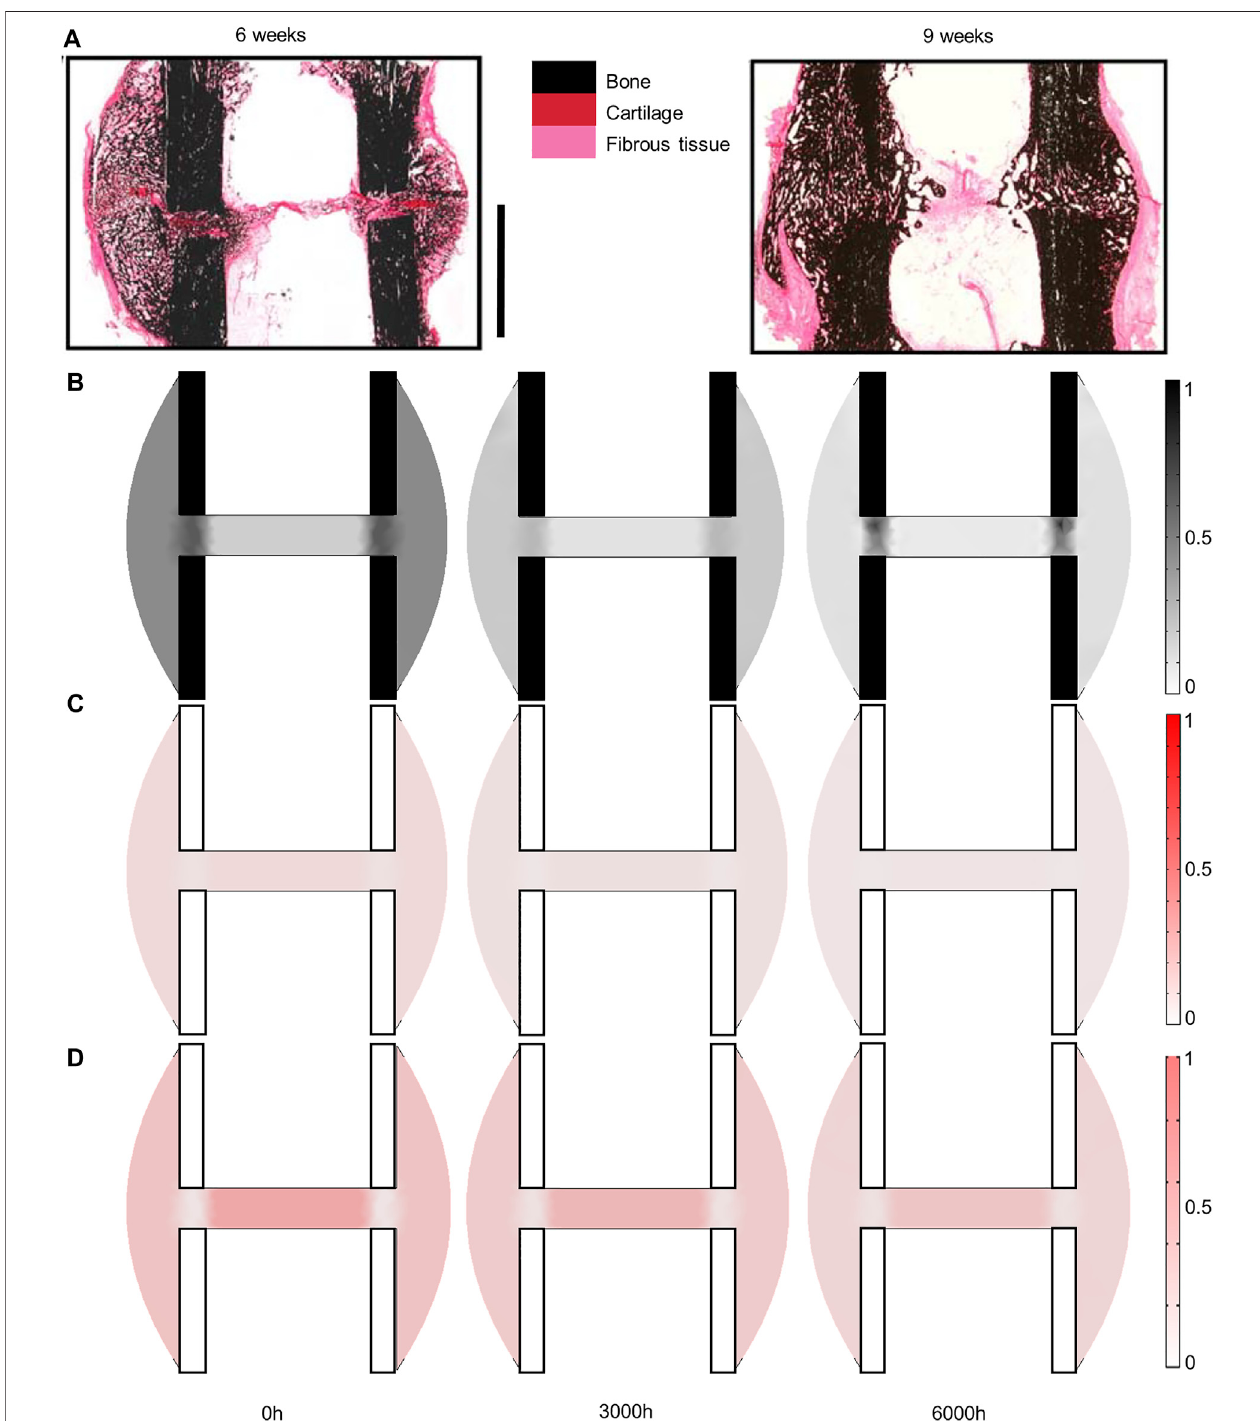
FIGURE 6 | Sheep fracture tissue distribution in the mid-sagittal plane: (A) experimental 6- and 9-week histology (reproduced with permission from (Epari et al., 2006) Copyright © 2005 Elsevier Inc.); (B) predicted mature bone fraction at 0, 3,000 and 6000h; (C) predicted mature cartilage fraction at 0, 3,000 and 6000h; (D) predicted mature fi brous tissue fraction at 0, 3,000 and 6000 h. Scale bar: 10 mm; fi xator was placed on the right of all images (medial side).